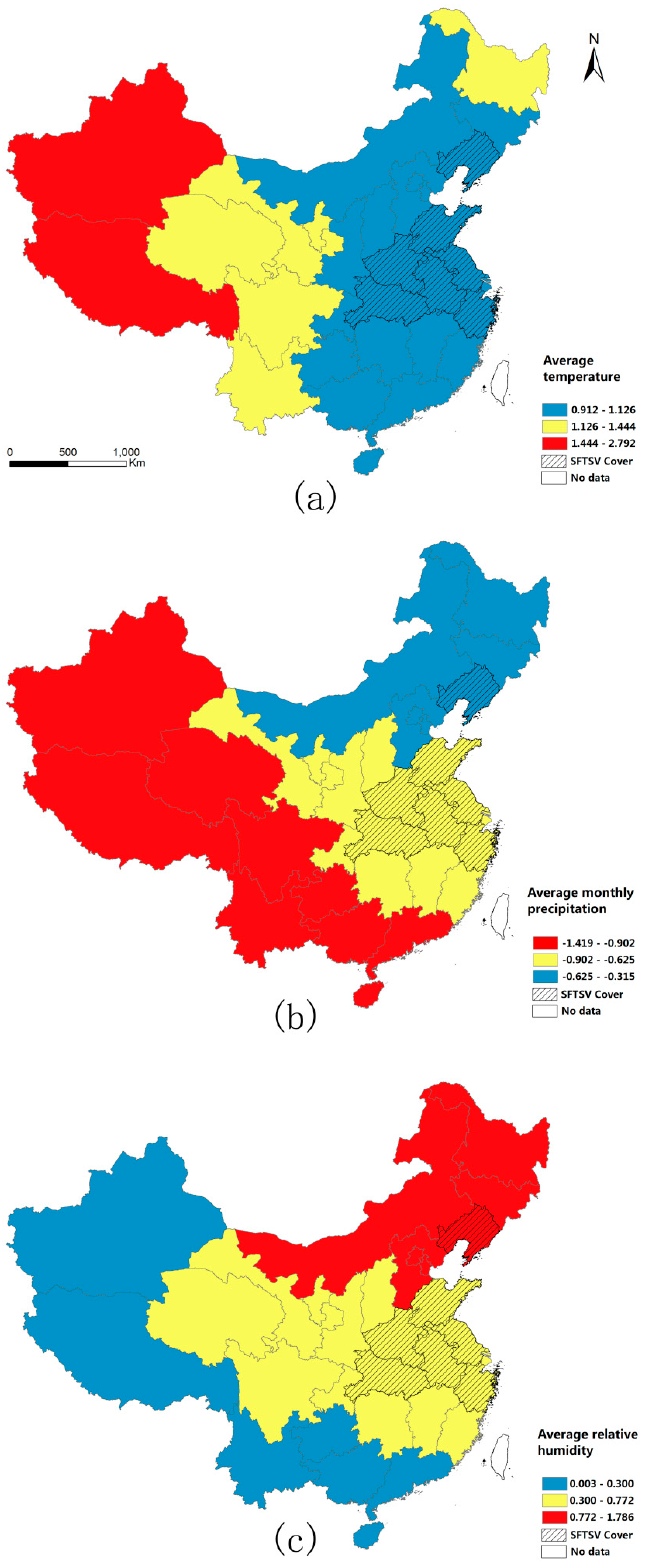
Figure 5. Spatial distribution of the local relationships between SFTSV cover and the three meteorological factors: ( a ) Estimated coefficient for average temperature; ( b ) Estimated coefficient for average monthly precipitation; and ( c ) Estimated coefficient for average relative humidity. SFTSV = severe fever with thrombocytopenia syndrome